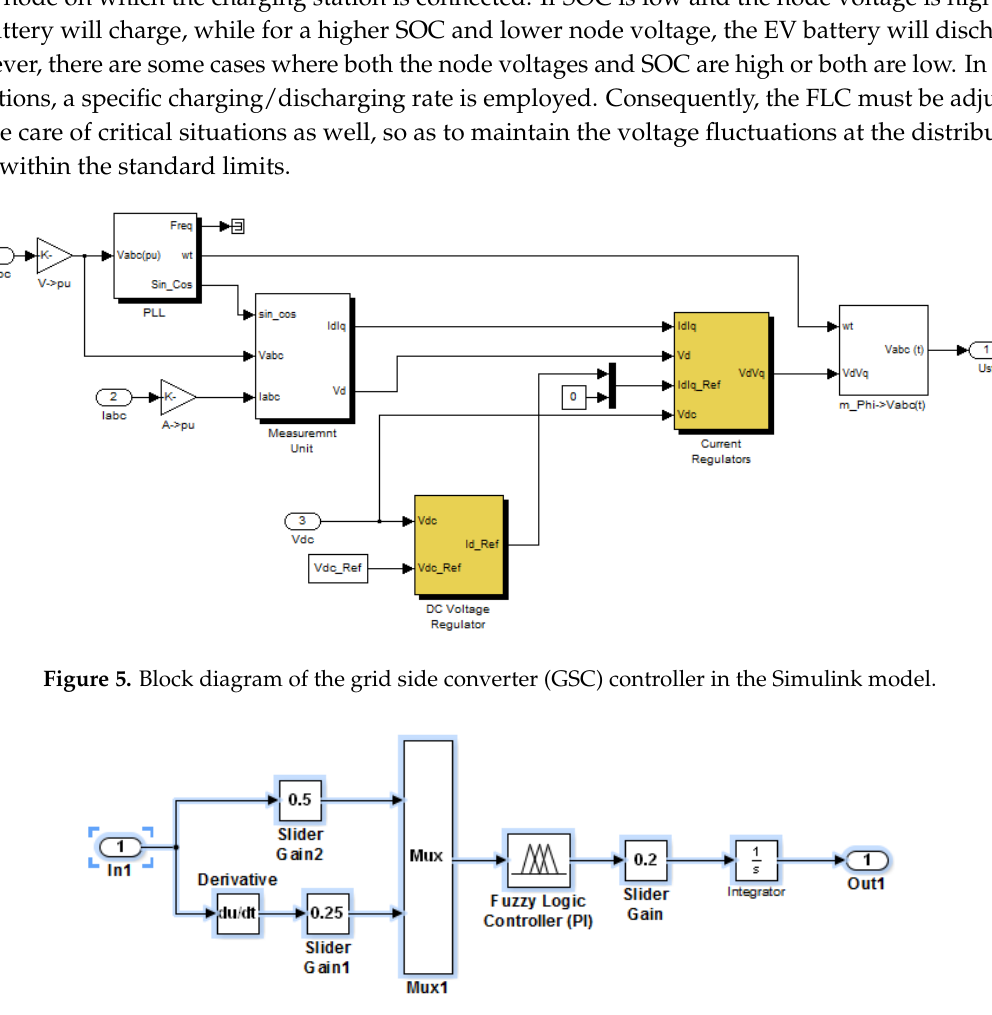
Figure 6. Block diagram of fuzzy logic PI controller for current regulator.